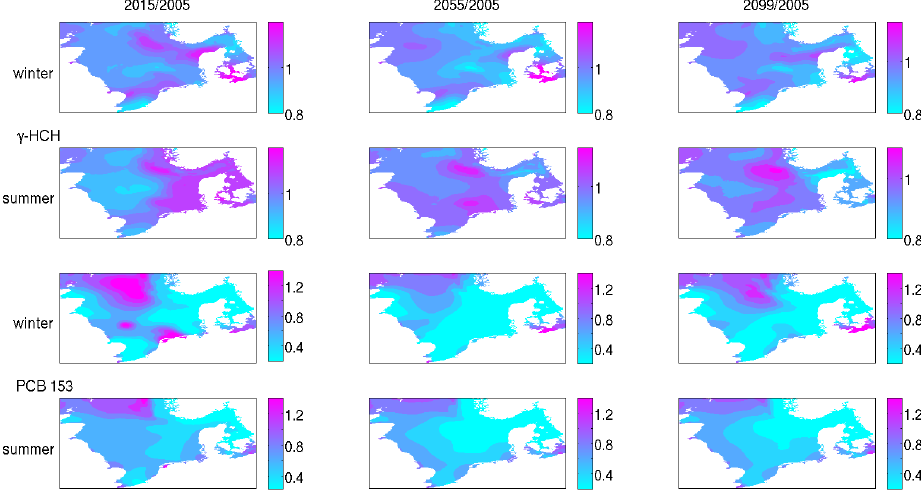
Figure 8. Distributions of concentration ratios integrated through the entire water column, 2015/2005, 2055/2005 and 2099/2005, from left to right, respectively, for γ -HCH in winter (top) and summer (second row), and for PCB 153 in winter (third row) and summer (bottom). Units are ngL − 1